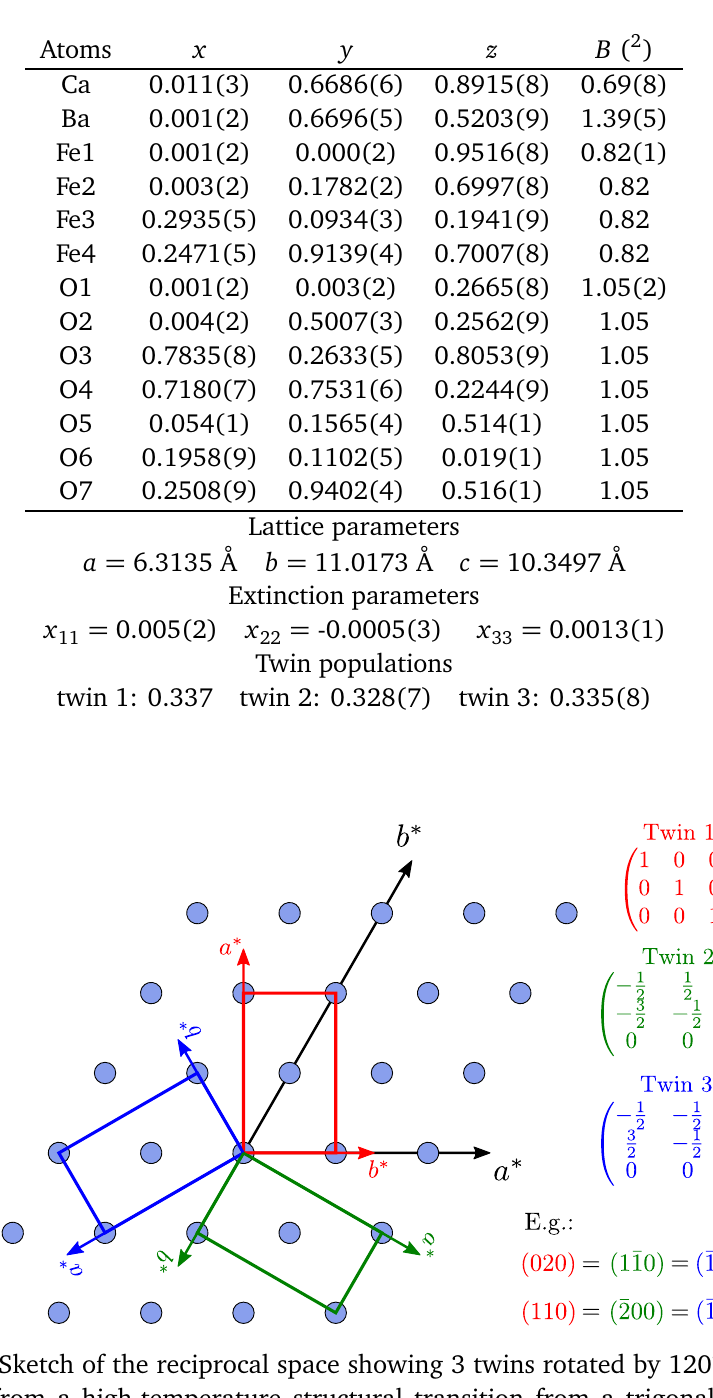
space group at RT 1